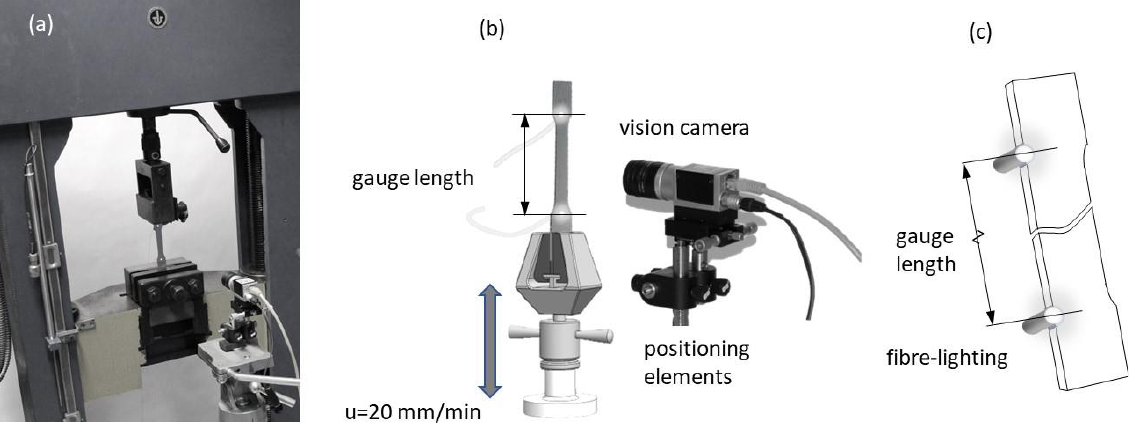
Figure 7. The proposed vision extensometer technique illustrations: ( a ) tension test measurement, ( b ) schematic illustration of the vision extensometer, ( c ) gauge length illustration.